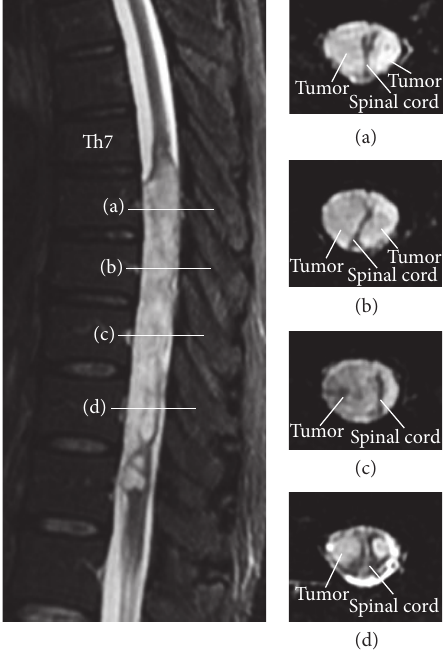
Figure 2: Axial T2WI at the Th8–11 level, showing an eccentric intramedullary tumor located bilaterally. Bars indicatelevels of axial views for Th8 (a), Th9 (b), Th10 (c), and Th11